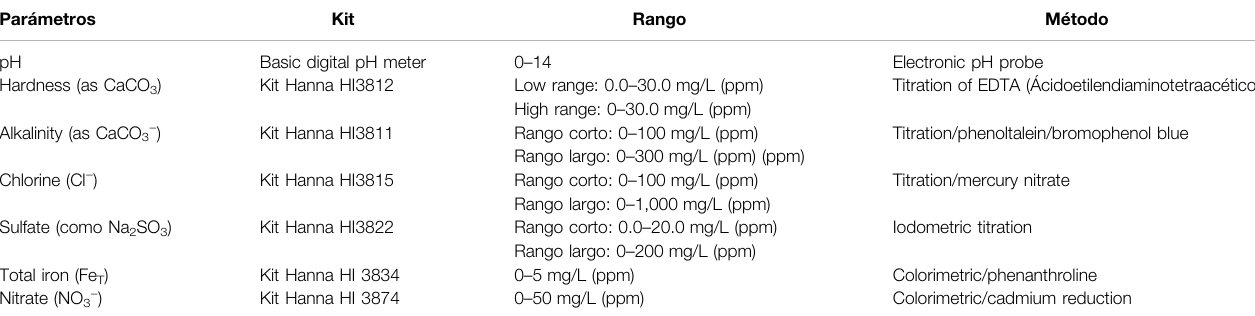
TABLE 2 | Physicochemical parameters used for water quality community monitoring.